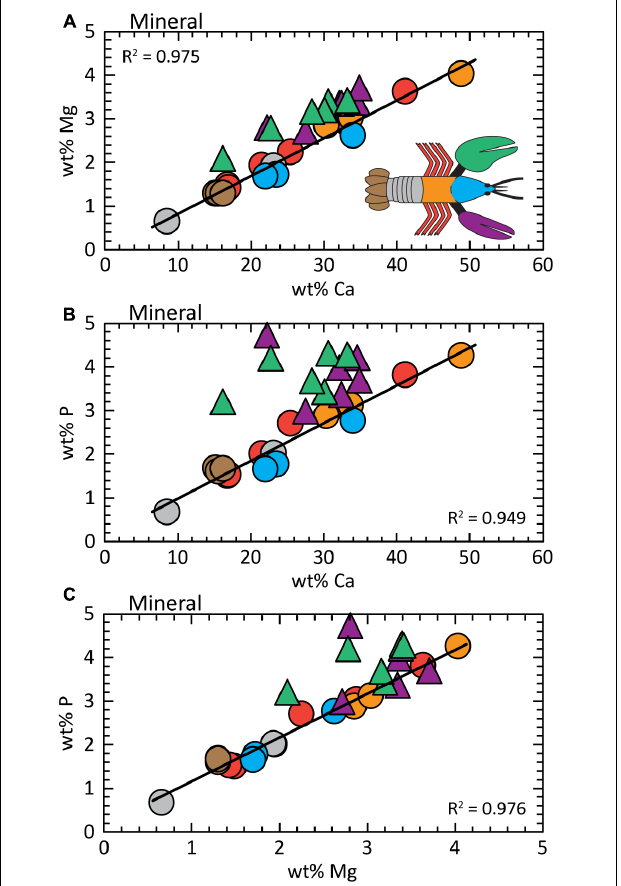
FIGURE 3 | Analysis of the mineral fraction shows element concentrations are covariant; chelae compositions are offset to higher wt% Mg and wt% P. (A) wt% Ca vs. wt% Mg; (B) wt% Ca vs. wt% P; (C) wt% Mg vs. wt% P. Regression fits are determined for the data from all body parts except the chelae. Detailed statistics are presented in Supplementary Table S3